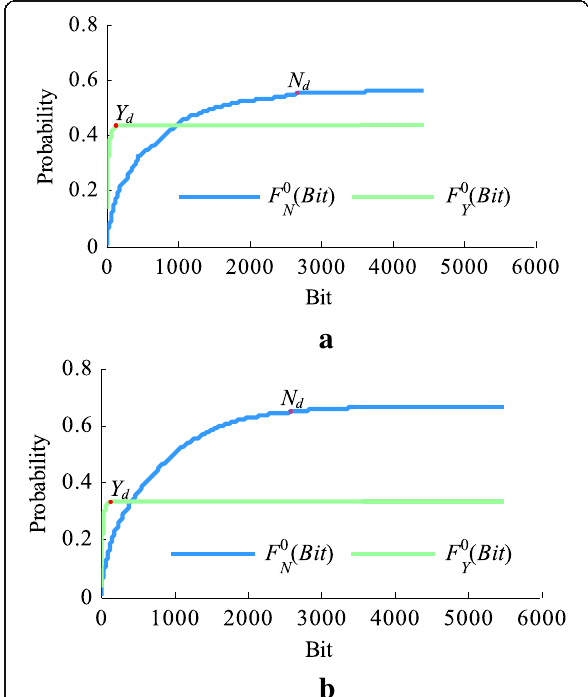
Fig. 7 Illustration of the probability function F 0